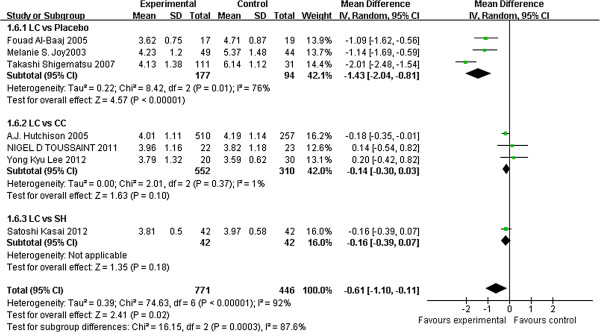
Forest plot of Ca × P product in patients treated with LC and control therapy. Studies were identified by name of the first author and year of publication. Mean differences (MDs) were pooled using the random-effect model and shown on a scale of −2 to 2.